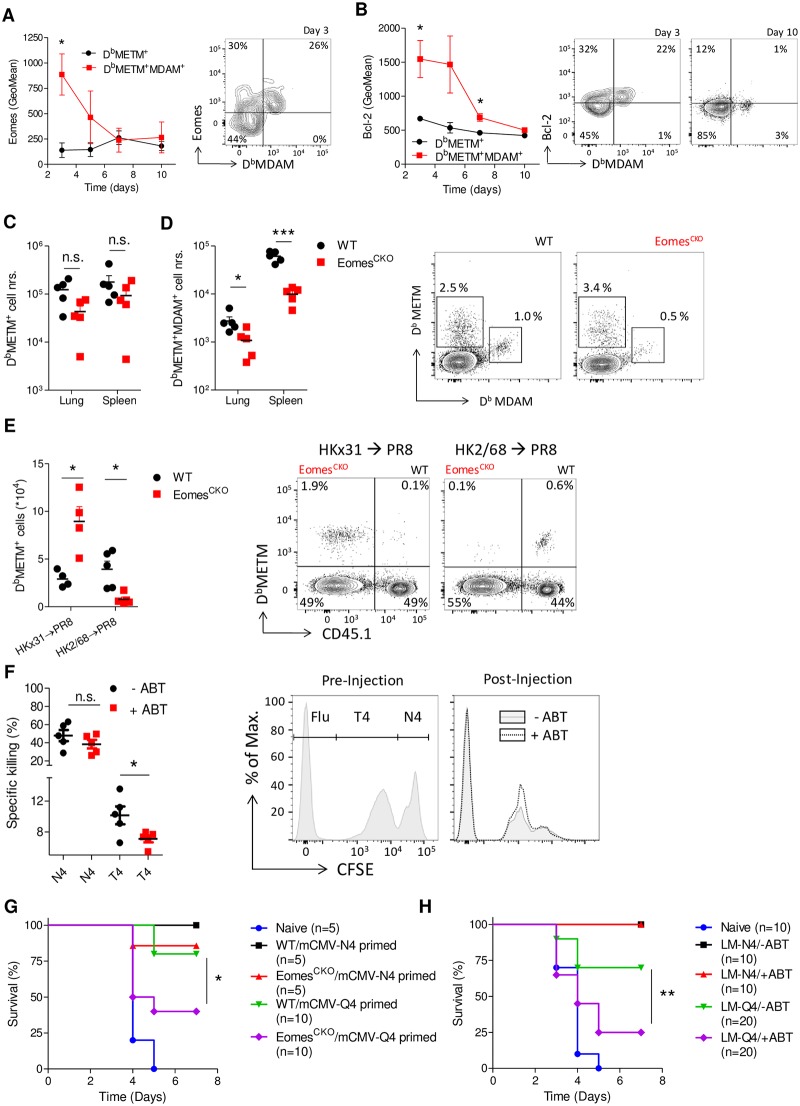
The Eomes/Bcl-2 axis promotes the ability of the memory pool to respond to mutated pathogens.(A,B) WT mice were infected intranasally with PR8, which carries the immunodominant epitope METM. At the indicated time points (A) Eomes and (B) Bcl-2 expression was quantified in DbMETM+ and DbMETM+DbMDAM+ CD8 T cells of the lung-draining lymph node. (C,D) mBMCs were infected intranasally with PR8. After 10 days, absolute numbers (“nrs.”) of (C) DbMETM+ and (D) DbMETM+DbMDAM+ cells were determined by flow cytometry. Representative plots show donor WT (left panel) and EomesCKO (right panel) CD8 T cells from the same animal in spleen. (E) mBMCs were infected with influenza A strain HKx31 (METM+) or HK2/68 (MDAM+). After 35 days, mice were reinfected with PR8 (METM+), and recall responses were determined after 10 days. Representative FACS plot shows donor CD8+ cells in spleen. (F) WT CD45.2+ mice were infected with mCMV. After 6 days, animals received ABT-199 (+ABT) or carrier only (-ABT). On day 35, mice were injected with CFSE-labeled CD45.1+ splenocytes, pulsed with control, N4, or T4 peptides. Specific killing of N4- or T4-pulsed target cells relative to control-pulsed control cells was determined in spleen by flow cytometry. Representative FACS plots for CFSE-stained populations pre- and post injection. Gated is for donor CD45.1+ cells. (G) WT OT-1 (WT) or EomesCKO OT-1 (EomesCKO) cells (104) were transferred to WT recipients and primed with mCMV-N4 or mCMV-Q4. After 30 days, mice were infected with a lethal dose of LM-N4 and survival was followed. Nonprimed (Naïve) mice were included as a control. (H) WT mice were infected with LCMV-N4 and, after 3 days, treated with ABT-199 or carrier only (-ABT). After 30 days, mice were infected with a lethal dose of LM-N4 or LM-Q4 and survival was followed. Naïve mice were included as a control. In (A-F), Student t test was used, and in (G,H), log-rank test was used to determine significant differences between groups. Shown are representative graphs of two (C-G) or three (A,B) experiments using 4–10 mice per group. (H) shows pooled data from two independent experiments. Shown are means ± s.e.m. *P < 0.05, **P < 0.01, ***P < 0.001. Values for each data point can be found in S1 Data. CFSE, carboxyfluorescein succinimidyl ester; EomesCKO, Eomesflox/flox CD4Cre; FACS, fluorescence-activated cell sorting; GeoMean, geometric mean; LCMV, lymphocytic choriomeningitis virus; LM, L. monocytogenes; mBMC, mixed bone marrow chimera; mCMV, murine cytomegalovirus; MDAM, ASNENMDAM; METM, ASNENMETM; N4, SIINFEKL; n.s., not significant; PR8, influenza A strain PR/8/34; Q4, SIIQFEKL; T4, SIITFEKL; WT, wild-type.